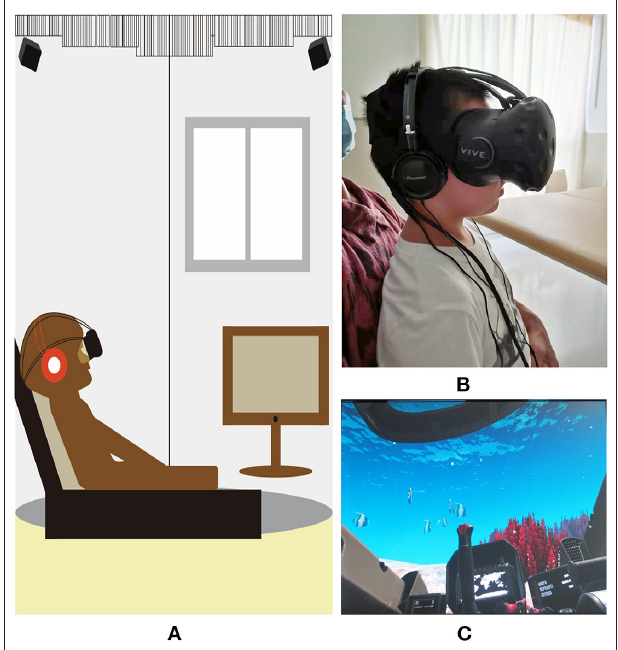
FIGURE 2 | Virtual reality headset and pictures. (A) The virtual reality system used in the study. The system includes head-mounted equipment, control handles, infrared locators, computer; (B) The patient is watching virtual reality video; (C) A picture of “Submarine VR”.